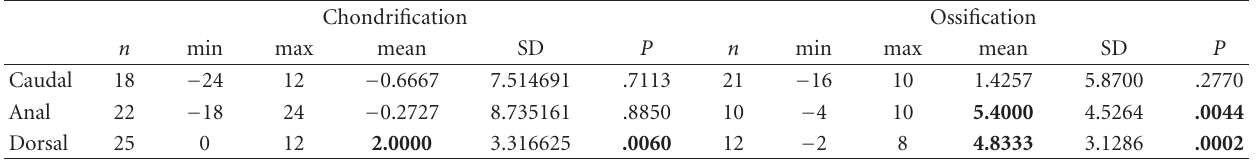
Figure 5: Formation of the fin rays for the three median fins of Salvelinus alpinus in Treatment S (a) and F (b) between day 20 and 90. Small and large symbols correspond to the presence of the cartilaginous actinotrichia and the ossification of the lepidotrichia, respectively. Table 1: Descriptive statistics for di ff erence in the first appearance of cartilaginous and ossified elements (dph in treatment S − dph in treatment F) for the three median fins of Salvelinus alpinus reared under two treatments of water velocity (treatments S and F). Positive di ff erences indicate that elements are forming earlier in the faster treatment, whereas negative di ff erences indicate that elements are forming earlier in the slower treatment. n is the number of coded elements for which the time of appearance was available for both treatments (less than 90 days). Min and max are the minimal and maximal di ff erence in dph, respectively. Mean and SD describe the average di ff erence. P is the probability associated with a t -test comparing the mean with a theoretical value of zero (no treatment e ff